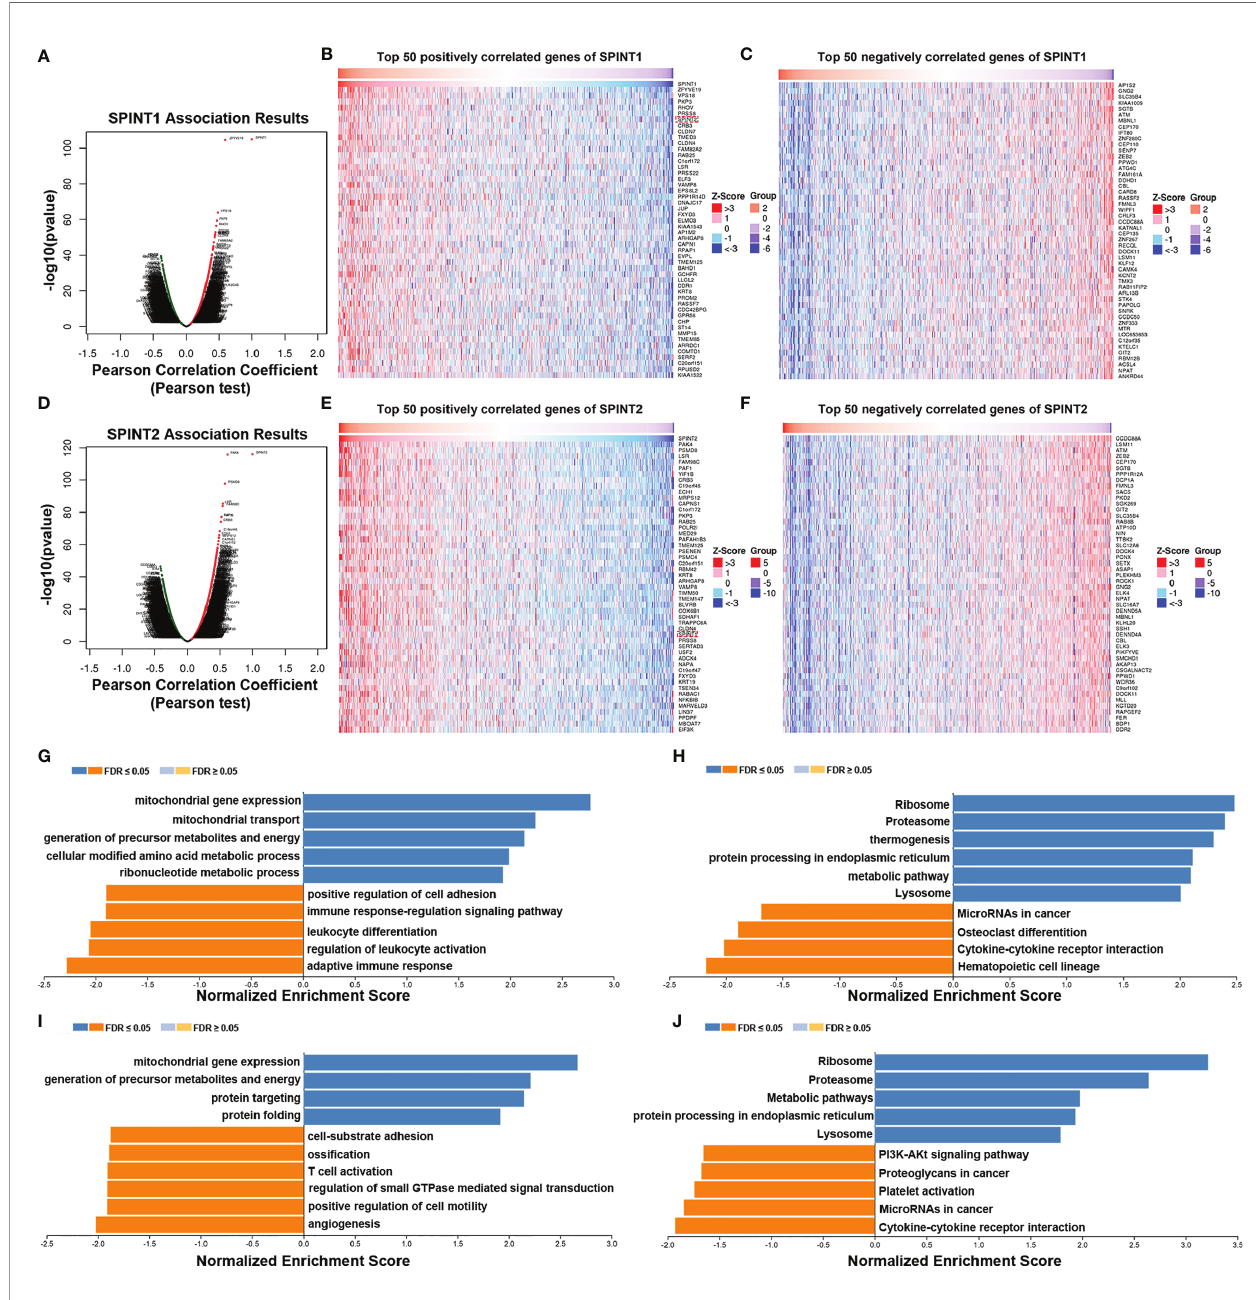
FIGURE 7 | Screening and enrichment analysis of SPINT1/2 co-expressed genes by Linkedomics. Volcano plot of SPINT1 co-expressed genes (A) . Top 50 positively (B) and top 50 negatively (C) correlated genes of SPINT1. Volcano plot of SPINT2 co-expressed genes (D) . Top 50 positively (E) and top 50 negatively (F) correlated genes of SPINT2. Biological process (G) and KEGG pathway (H) enrichment of the SPINT1 co-expressed genes. Biological process (I) and KEGG pathway (J) enrichment of the SPINT2 co-expressed